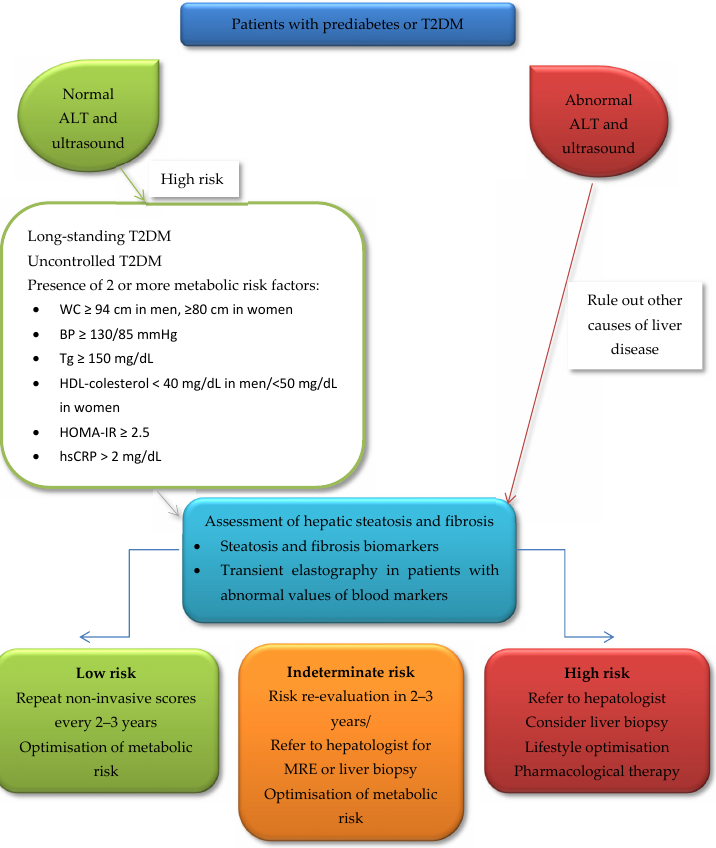
Figure 1. A suggested algorithm to screen patients with T2DM for NAFLD and advanced fibrosis [2,33,63,141]. Abbreviations: ALT, alanine aminotransferase; WC, waist circumference; BP, blood pressure; Tg, triglycerides; HOMA-IR, homeostatic model assessment for insulin resistance; hsCRP, high-sensitive C-reactive protein.